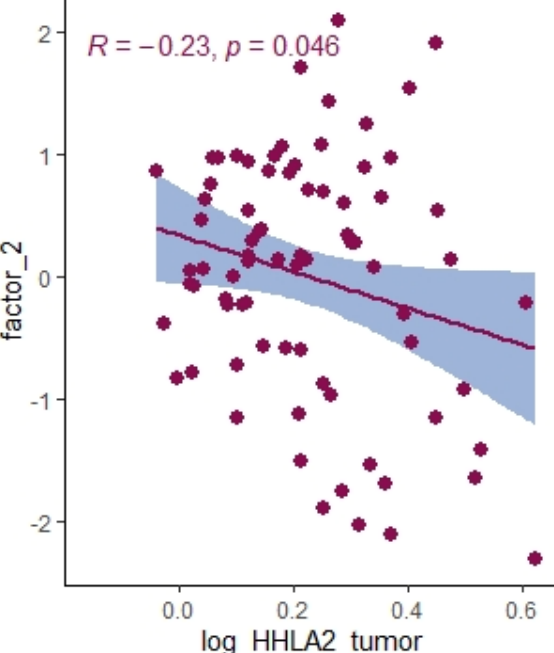
Figure 10. Correlation between HHLA2 tumor concentration factor 2 from principal component analysis containing cytokines IL-1a, IL-12, IL-13,